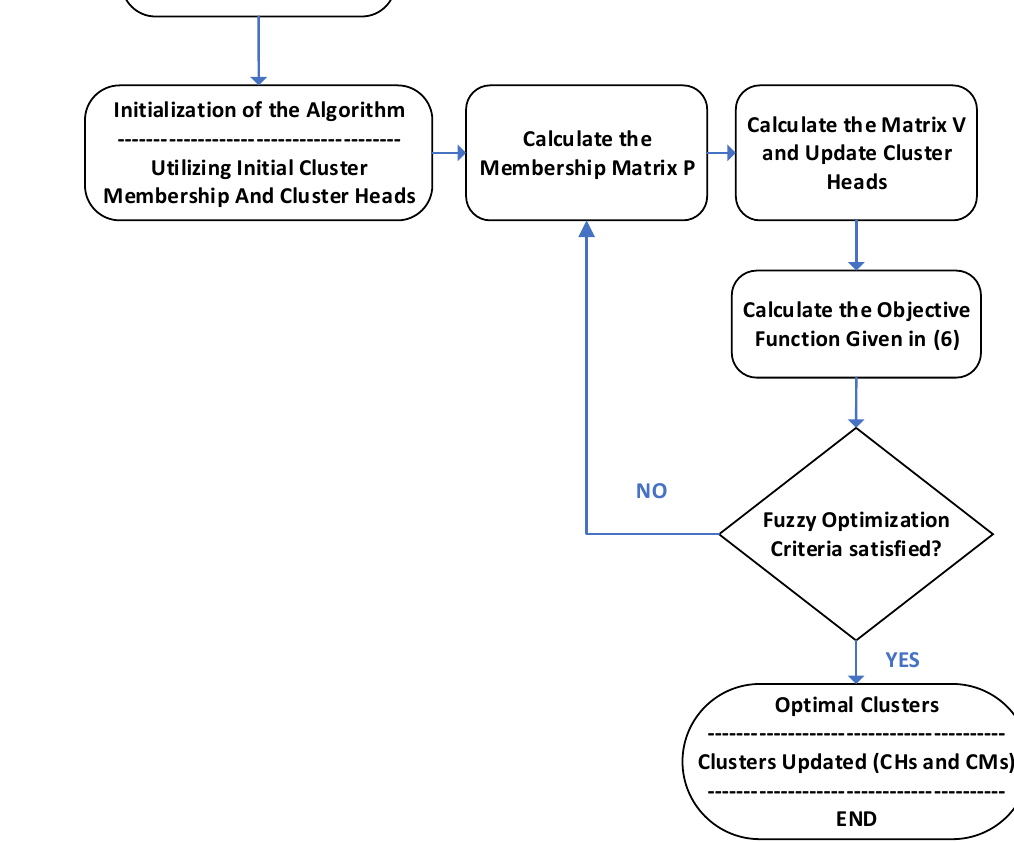
Figure 6. Optimization flow chart.